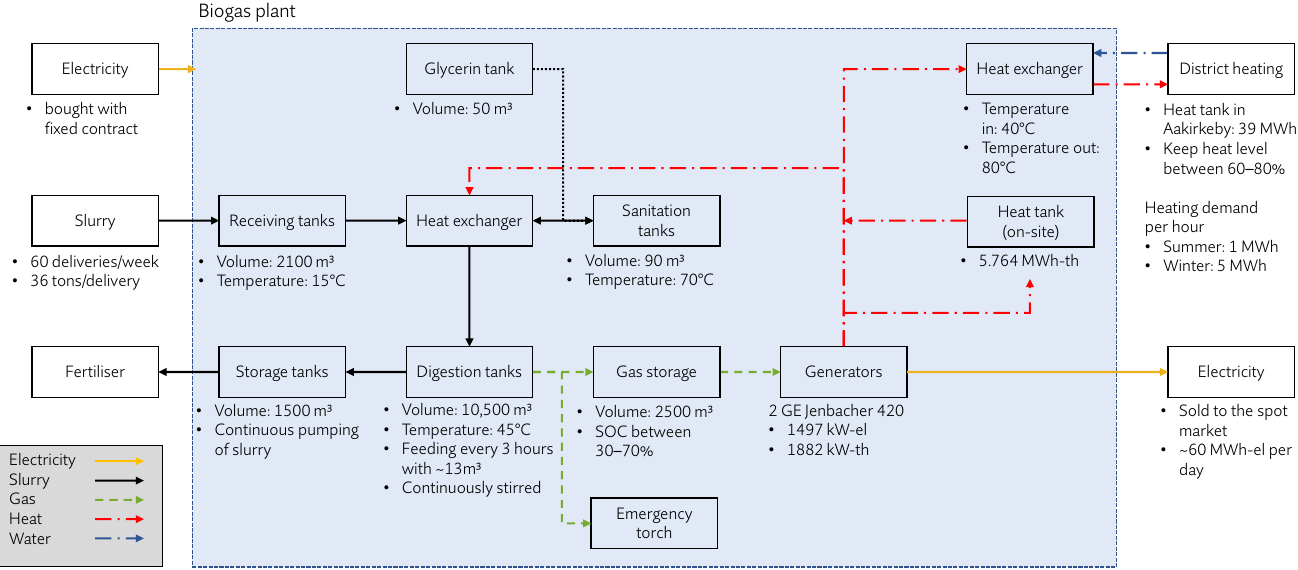
Figure 1. Block diagram of the biogas plant’s processes.